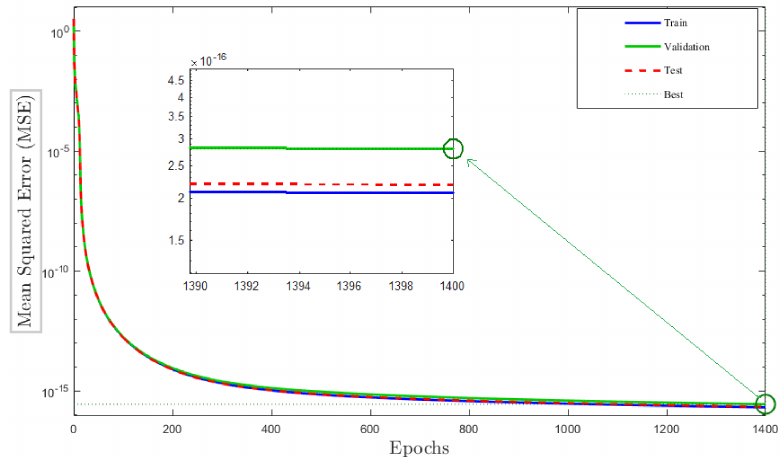
Figure 5. Mean squared error (MSE) of neural network model with two hidden layers. Table 1. Neural network model specifications—small strain elasticity.